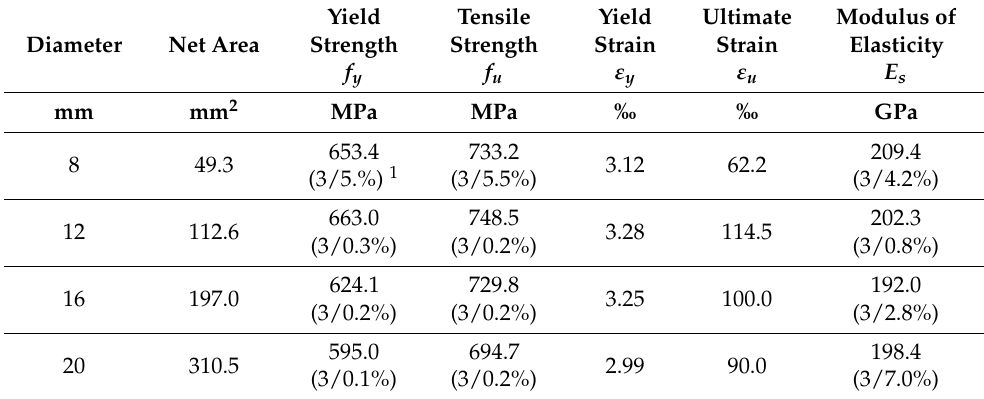
Table 2. Properties of the steel reinforcing bars used.